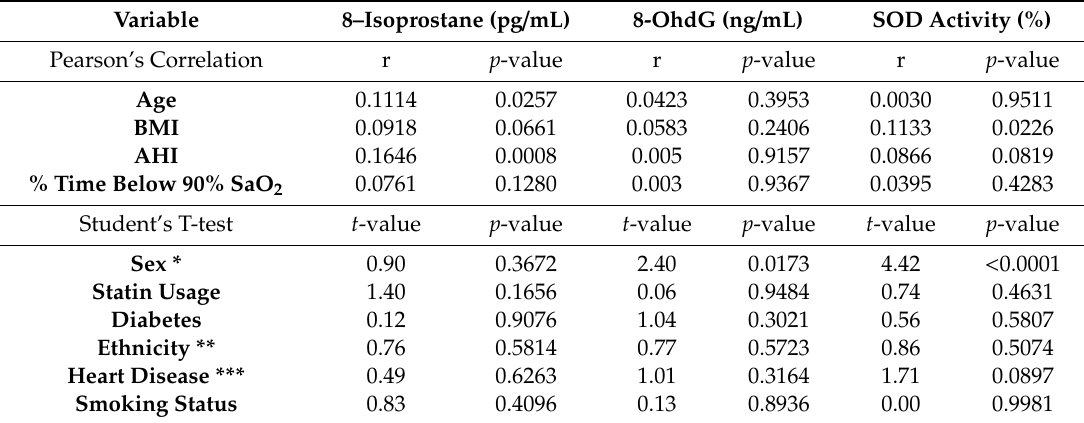
Table 2. Univariate Analysis.